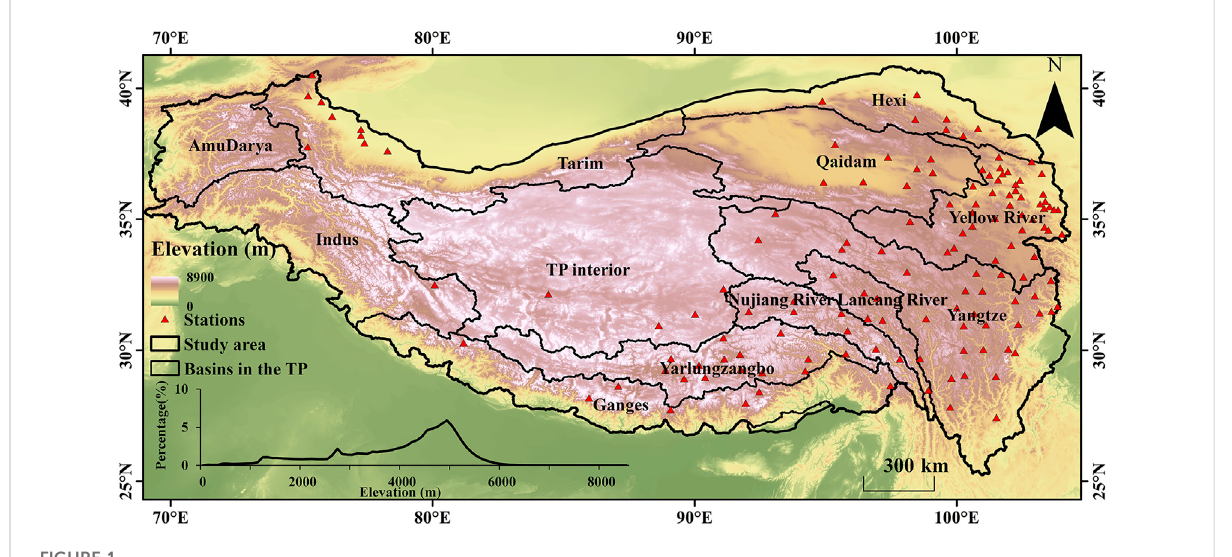
FIGURE 1 Study area and locations of 139 snow observation